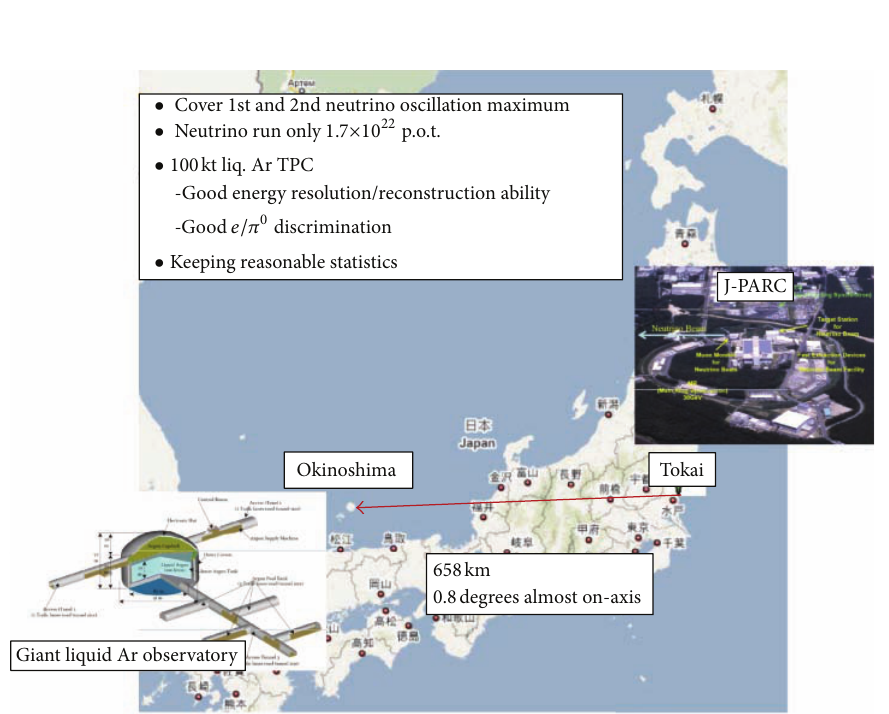
Figure 11: J-PARC to Okinoshima long-baseline neutrino